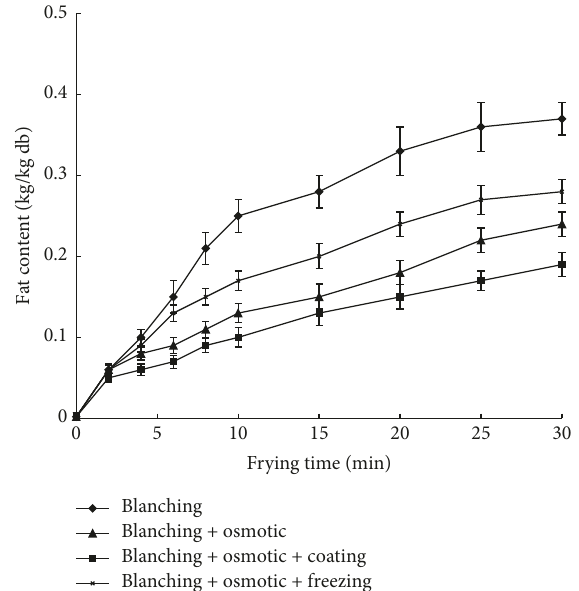
Figure3: Effectofdifferentpretreatmentsonoil contentofvacuum- fried shiitake mushroom